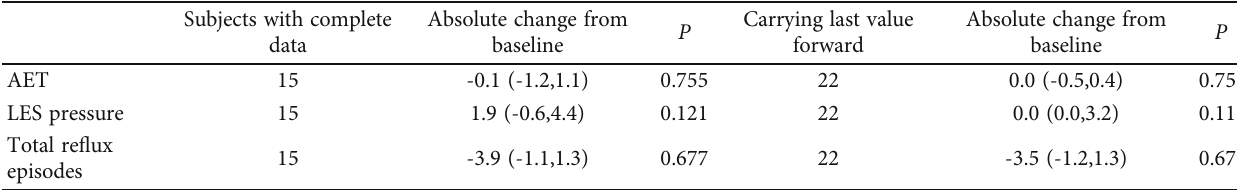
Table 4: Absolute di ff erences in AET and LES pressure at baseline and 12 mo after